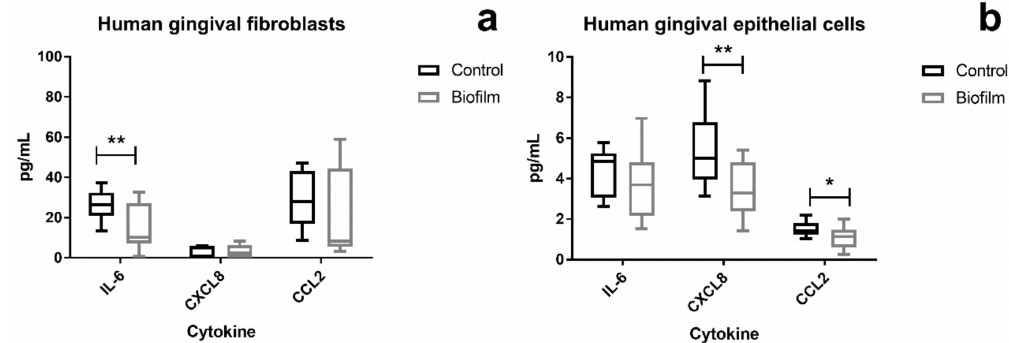
Figure 5. Levels of secreted proinflammatory cytokines from peri-implant tissue cells after 2 h co-culture with the S. oralis biofilm. Cytokines were measured using a Bio-Plex Kit for multiplex analysis. In HGFs, interleukin 6 (IL-6) levels were significantly reduced after co-culture ( a ). The interleukin 8 (CXCL8) and CCL2 levels were significantly reduced in HGEps after biofilm challenge ( b ). Data were tested for normal distribution (D’Agostino–Pearson normality test) and statistical significance was determined using the multiple T-test with corrections for multiple comparisons using the Holm–Sidak method, when p < 0.05. Data points are represented as Box and Whiskers with Tukey error bars. Asterisks